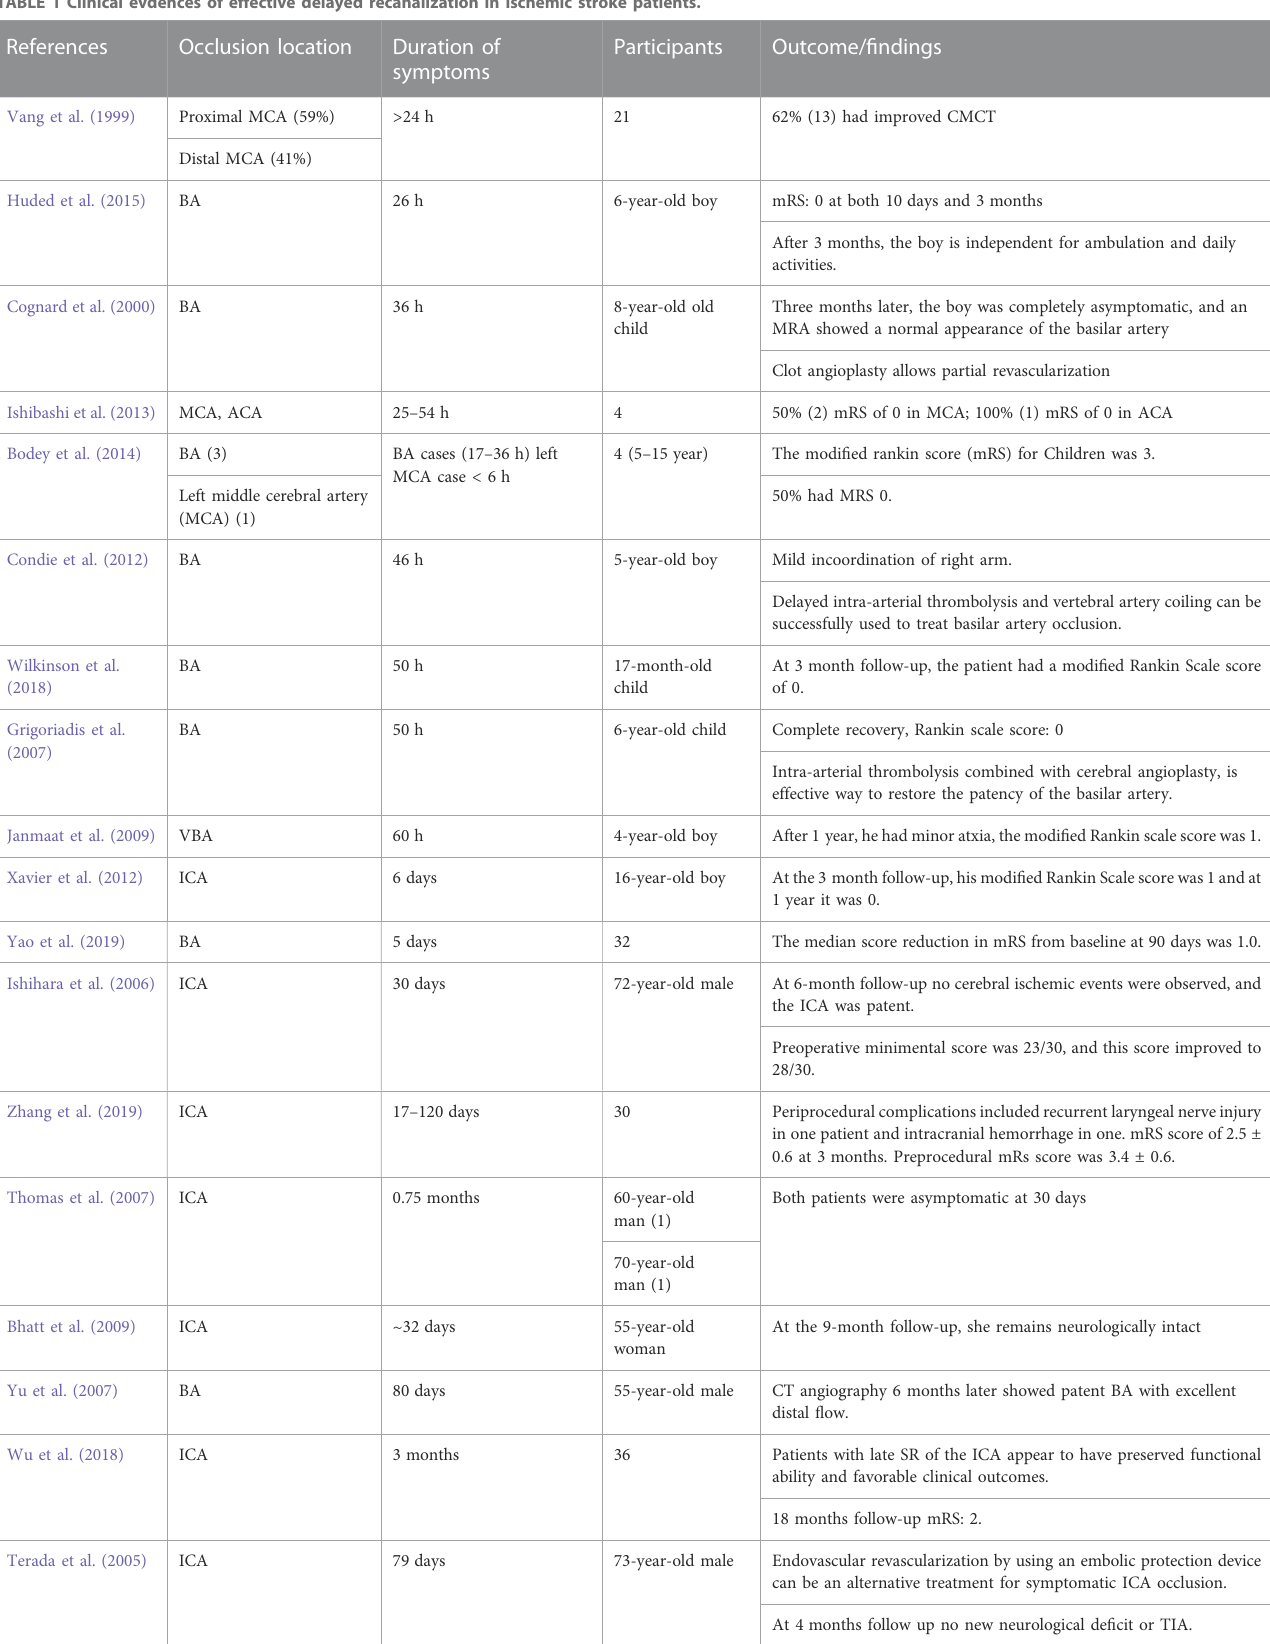
TABLE 1 Clinical evdences of effective delayed recanalization in ischemic stroke